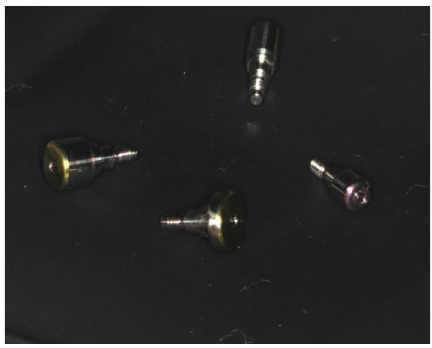
Figure 1: Gingiva formers of various